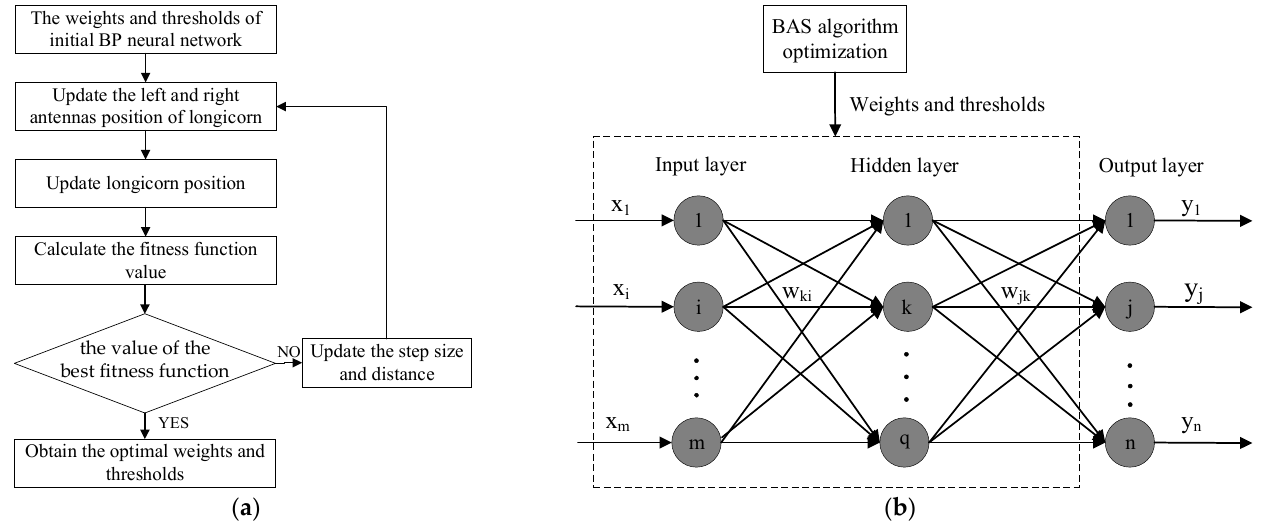
Figure 6. Schematic diagram of the optimization structure of the BAS-BP neural network: ( a ) BAS algorithm optimization; ( b ) neural network structure.